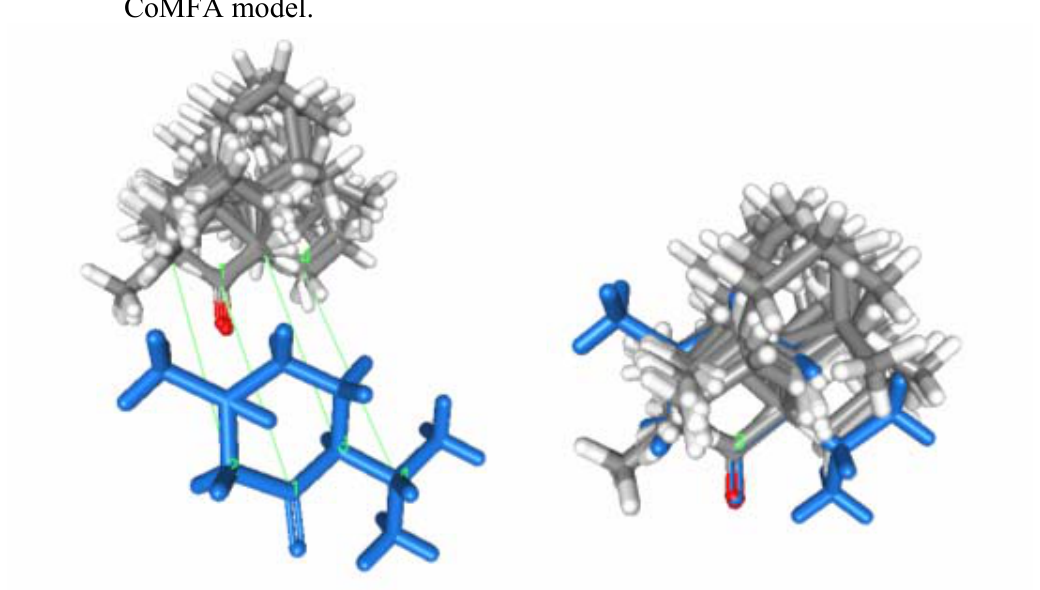
Figure 7. Alignment of menthone to the fitting model of the substrates selected for the CoMFA